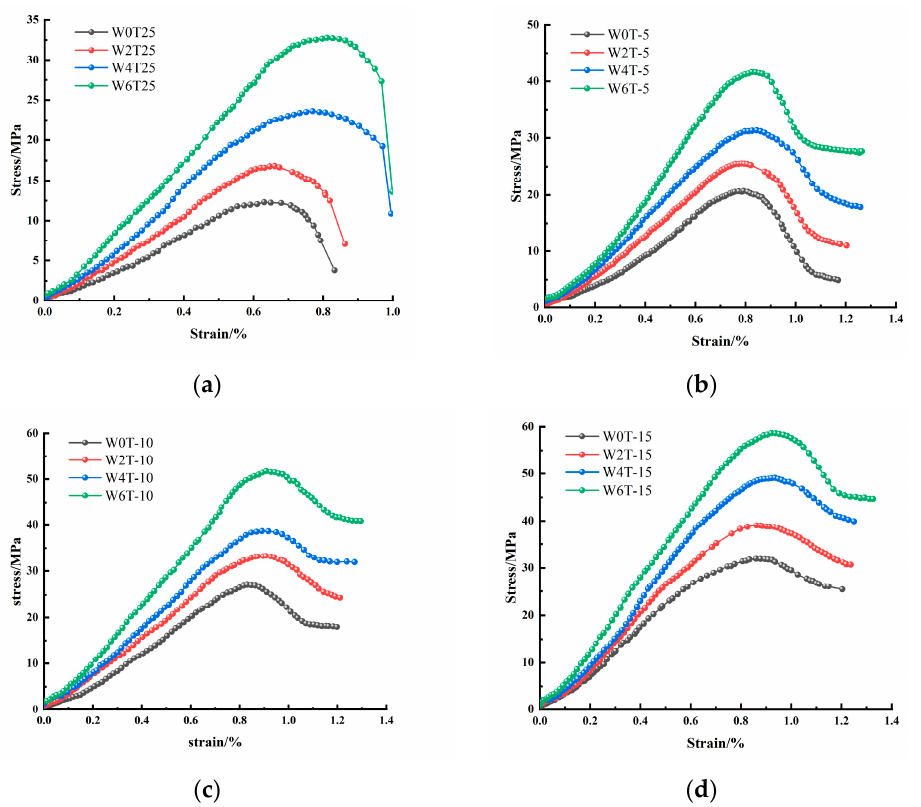
Figure 5. Stress–strain curve of red sandstone under triaxial compression. ( a ) T = 25 °C; ( b ) T = − 5 °C; ( c ) T = − 10 °C; ( d ) T = − 15 °C.